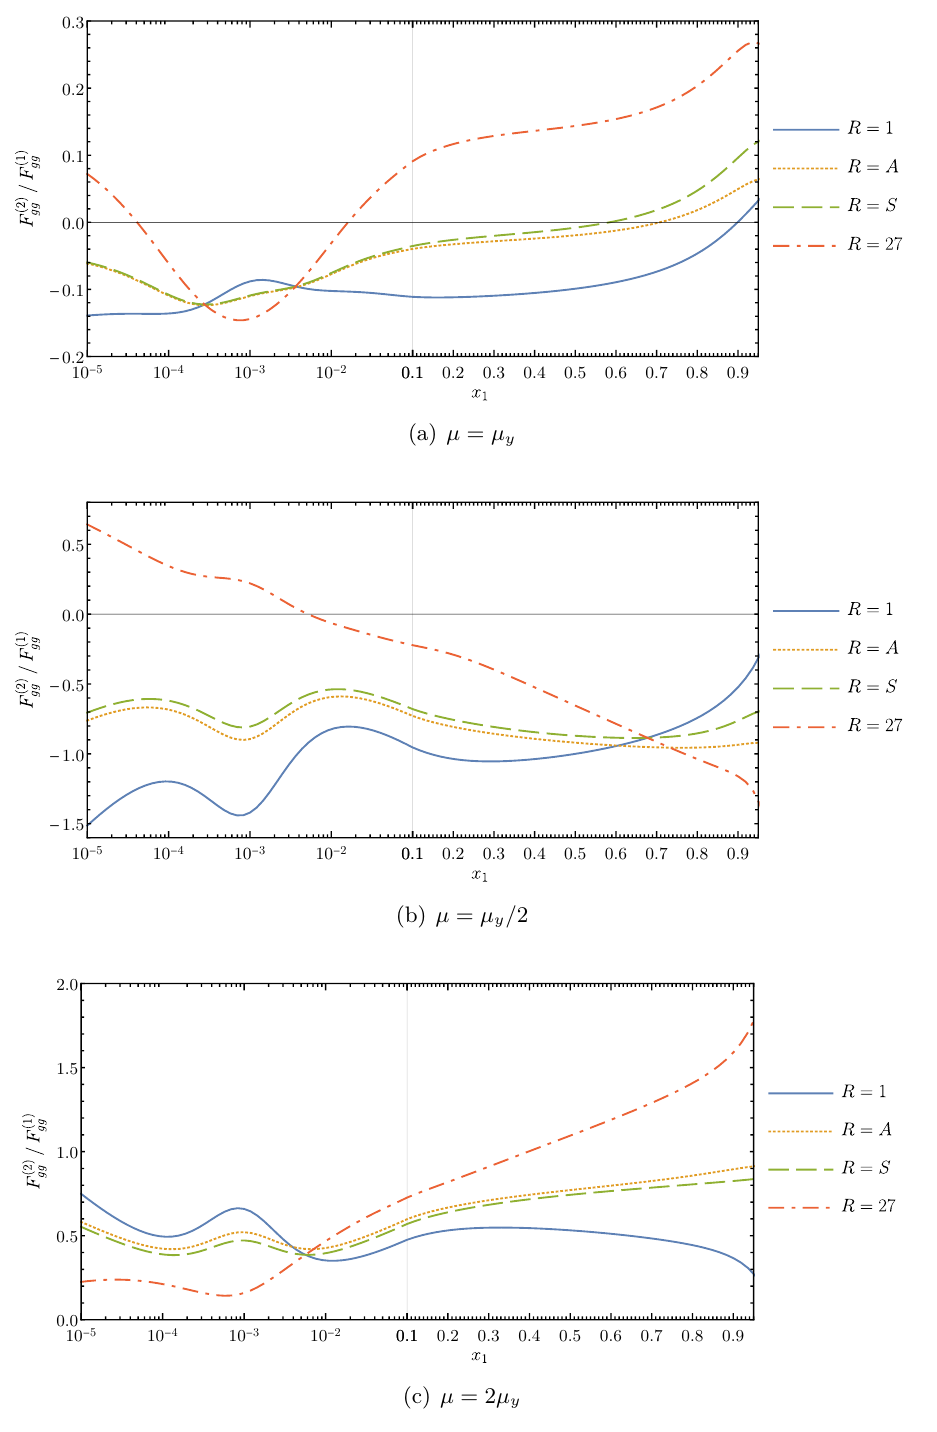
(cid:14) RR Figure 13 . The ratio RR F (2) gg F (1) gg for x 2 = 10 − 3 , evaluated at different values of the scale µ = µ . The plot in panel (a) is the same as in figure 9(c) and shown again for easier at p x 1 x 2 ζ p y